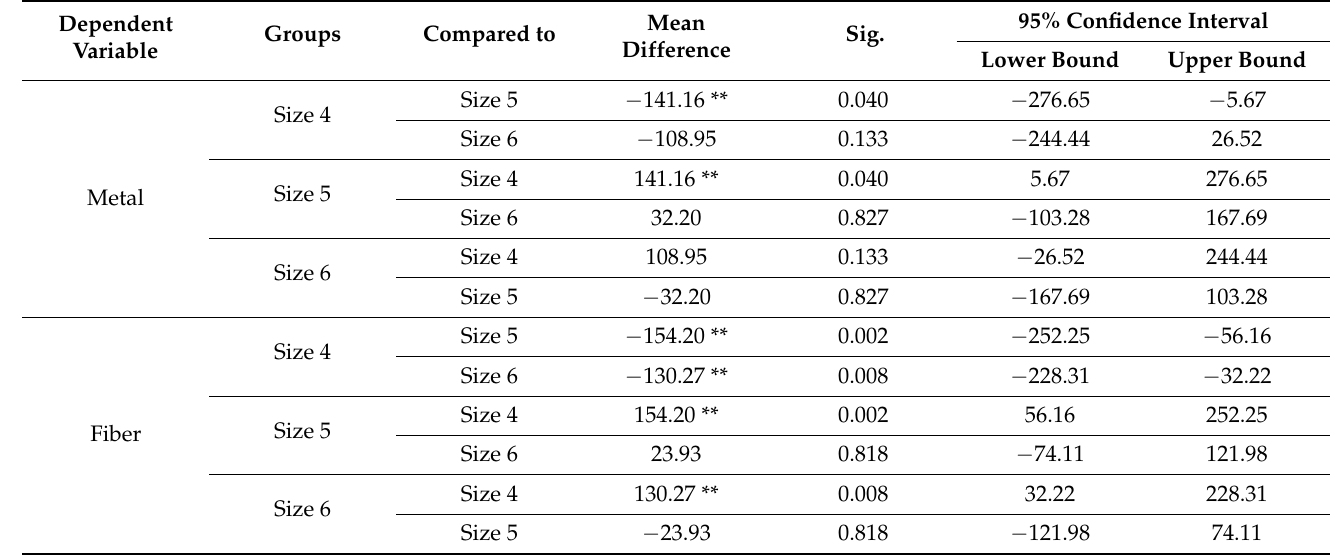
Table 3. Multiple comparisons and mean differences of the *PBS by Tukey HSD post-hoc